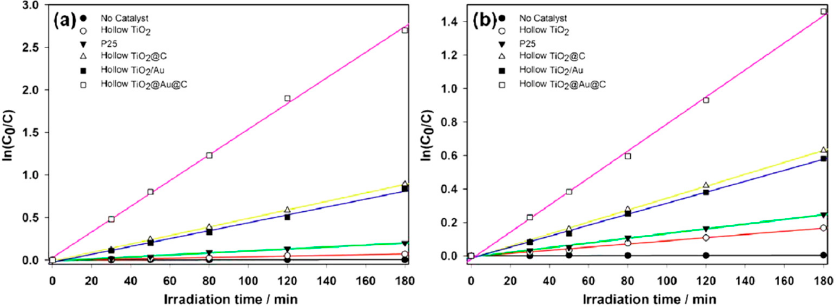
Figure 11. Linear transform ln(C 0 /C) = f(t) of the kinetic curves of ( a ) 4-nitroaniline or ( b ) 4-nitrophenol